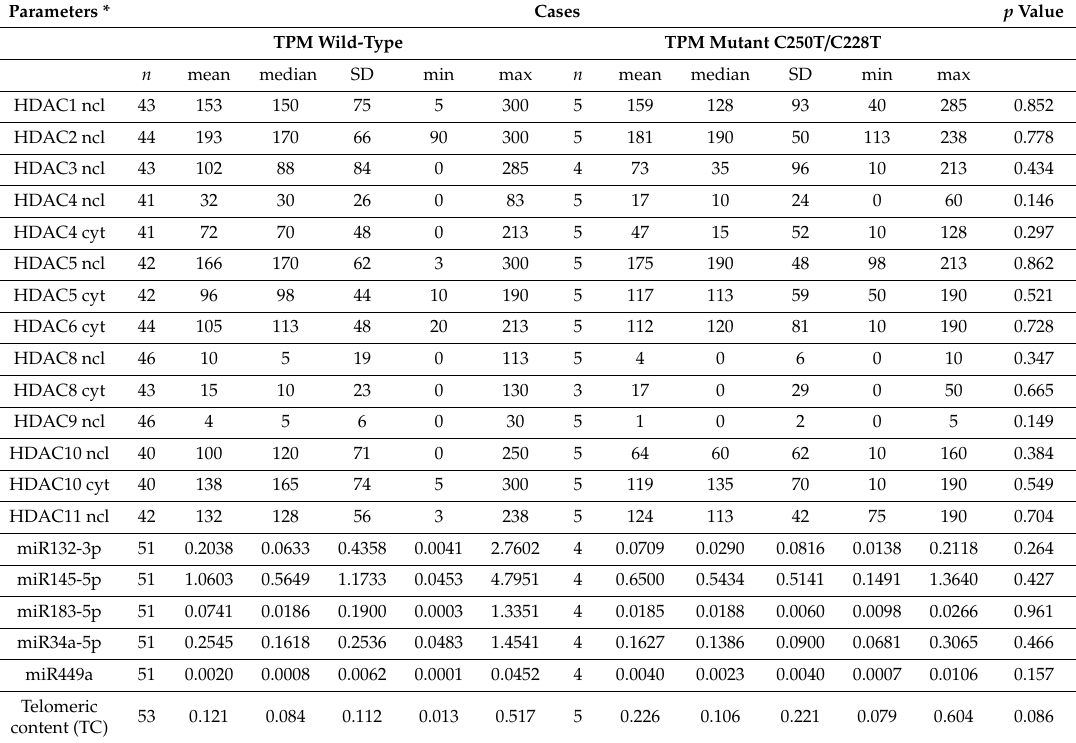
Table 3. Correlation of TPM status with telomeric content, histone deacetylase (HDAC) expression and miRNA